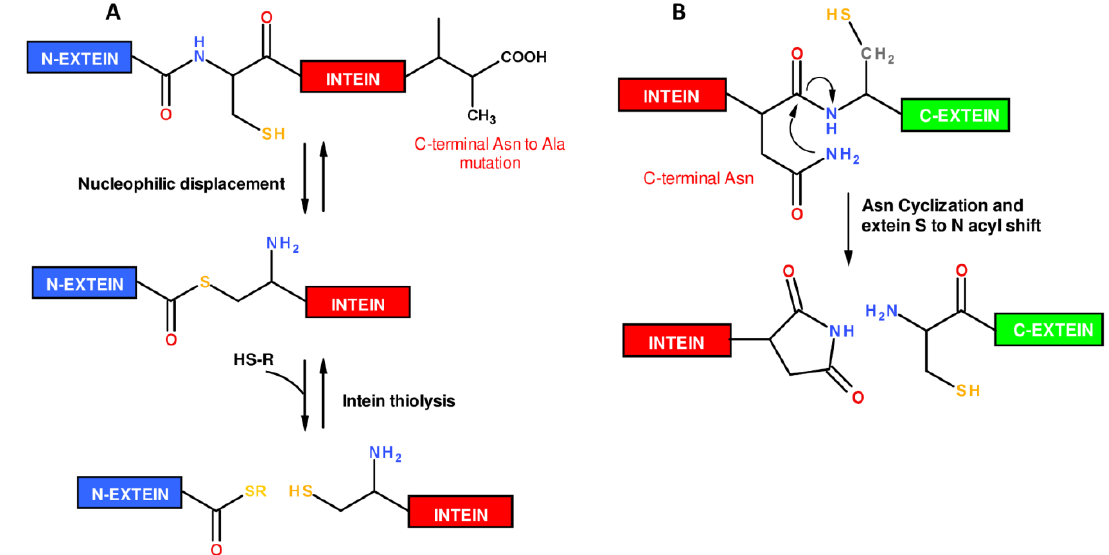
Figure 5. Schematic representation of reactions performed by engineered inteins yielding α -thioester proteins ( A ) or N-terminal cysteinyl-proteins ( B